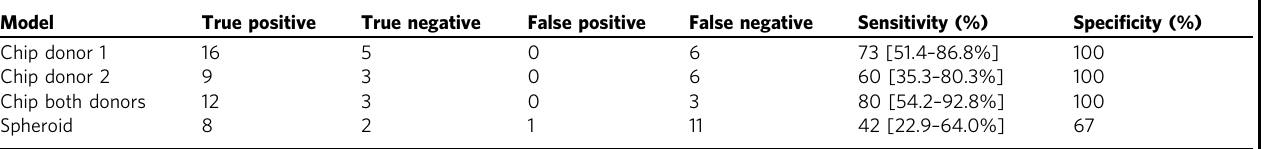
Table 5 Sensitivity and speci fi city determination.